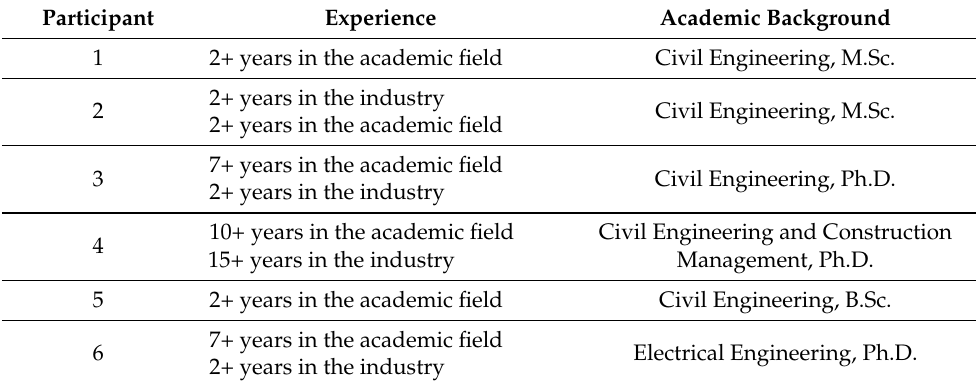
Table 1. Summary of the profile of the participants in the